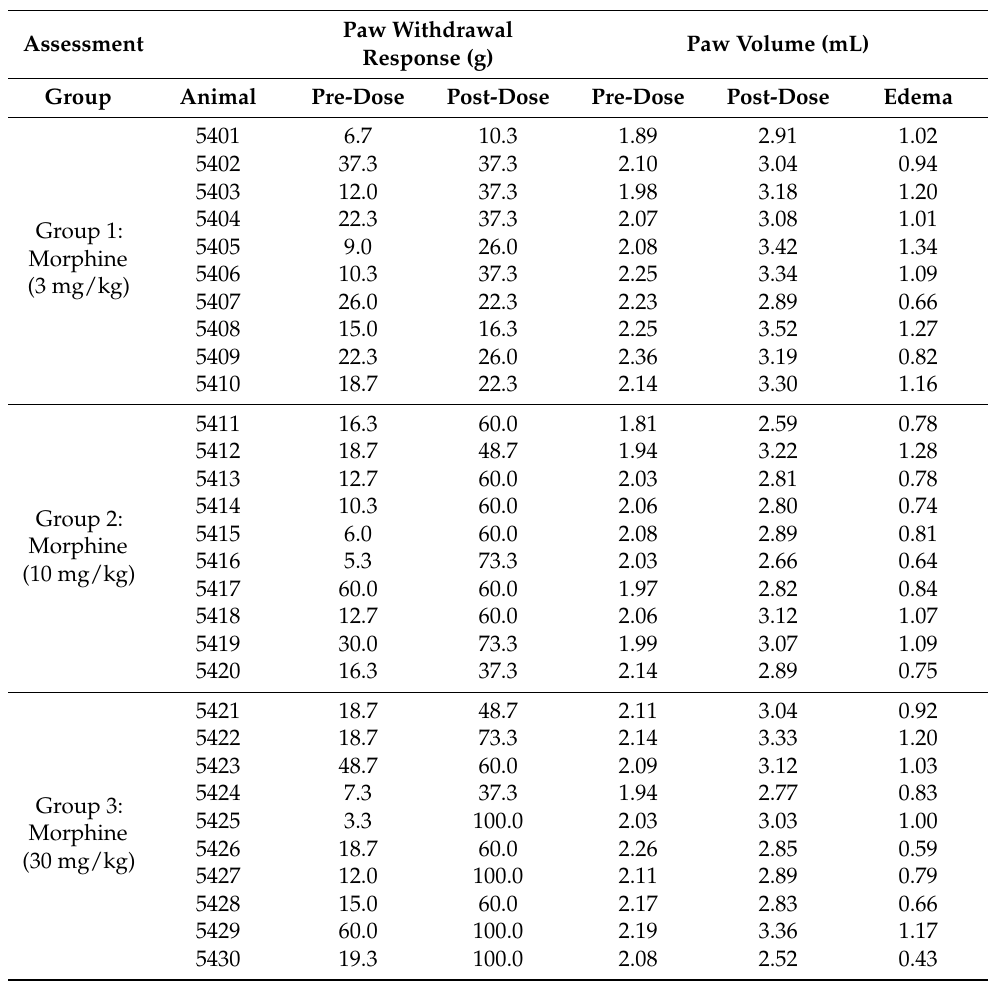
Table A1. Individual Data, Study